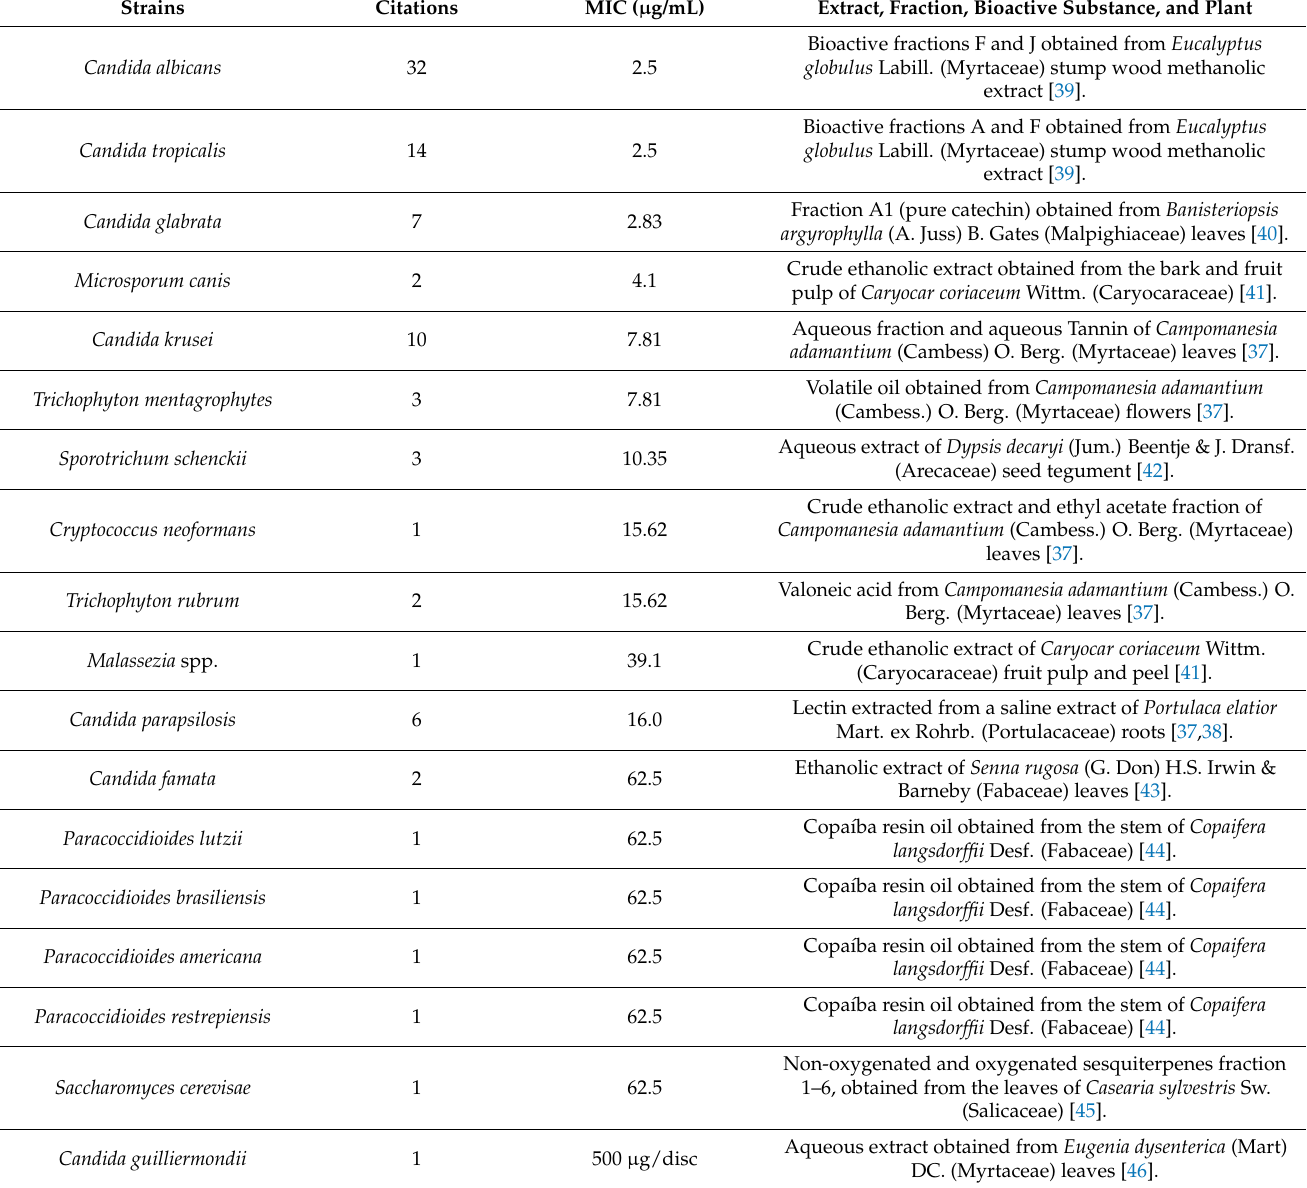
Table 2. Minimum inhibitory concentration (MIC) and the number of citations for antifungal